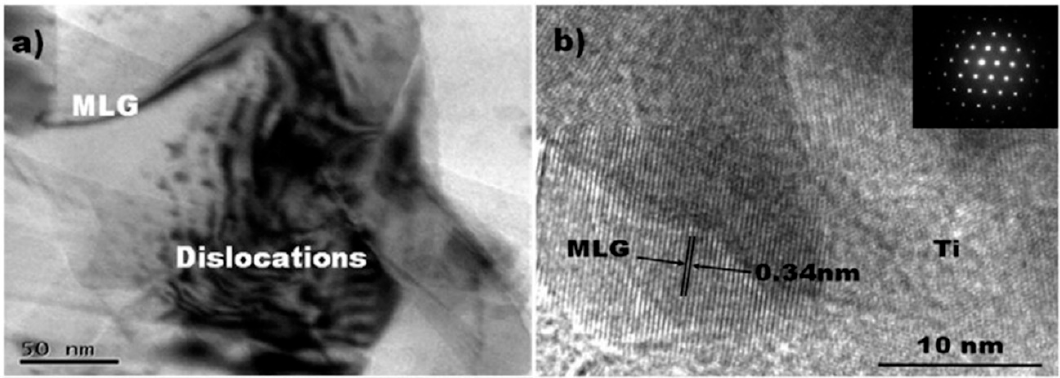
Figure 2. ( a ) TEM image showing dislocations within Titanium phase; ( b ) HRTEM image showing clean MLG-Ti interface (inset the selected area diffraction patterns of Titanium) of 0.5 wt. % MLG/Ti composite [34].